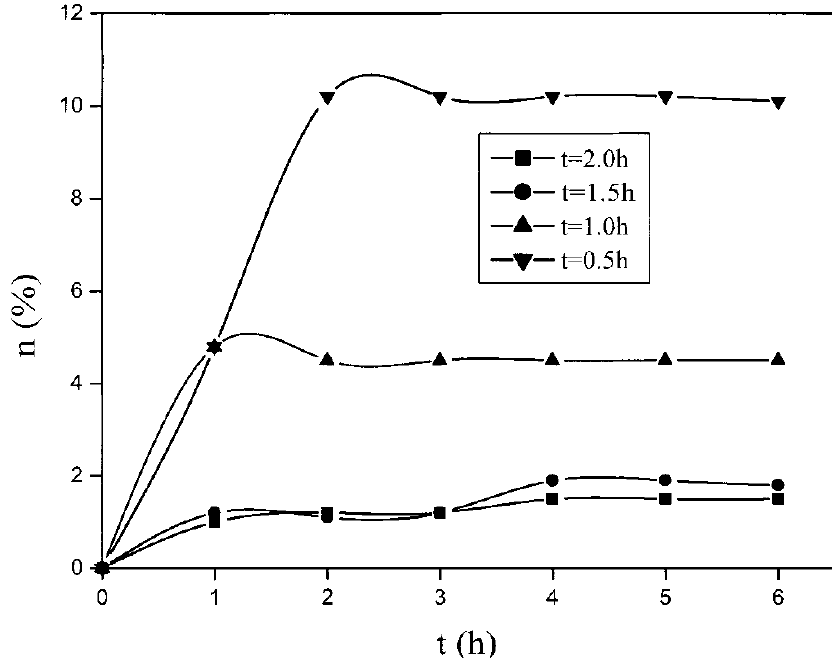
FIGURE 4 Influence of curing time on n under pressurised vapour method for samples cured at 150